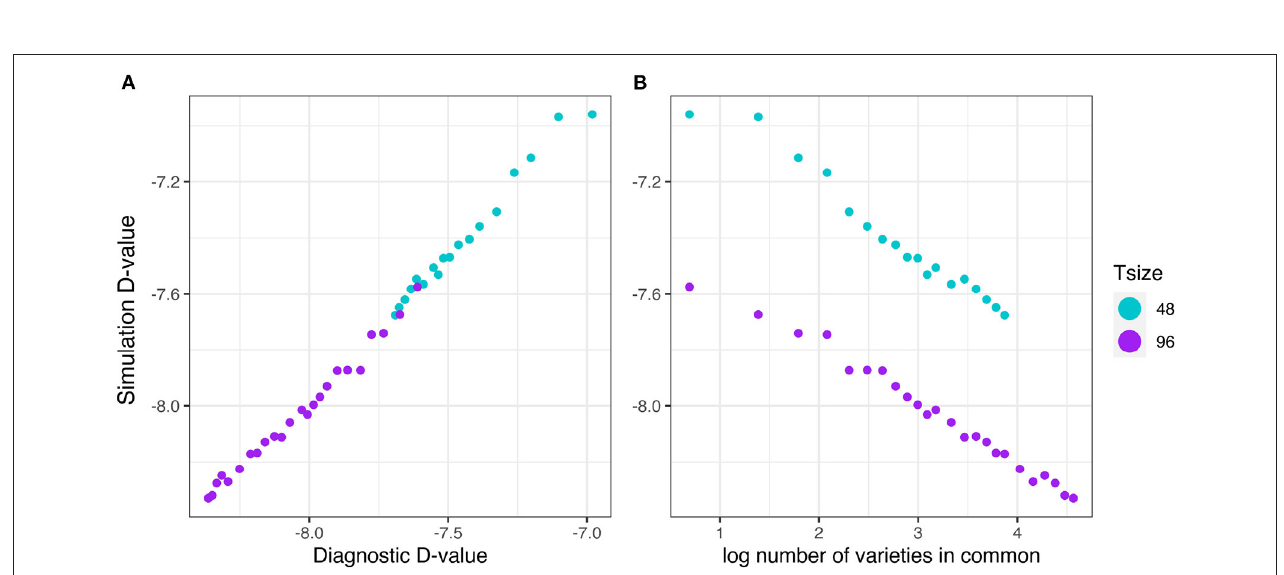
FIGURE 9 | Additive VE effects simulation study: Simulation based D S 1 c (A)-values plotted against (A) diagnostic D 1 c (A)-values and (B) log number of varieties in common for two trial sizes (trials with 48 and 96 varieties) and a sequence of connectivity levels. Trial sizes (Tsize) are represented using different colours. Each point within Tsize corresponds to a different level of variety connectivity which ranges from c = 2 up to the number of varieties in a trial (representing 100% connectivity between the two trials).